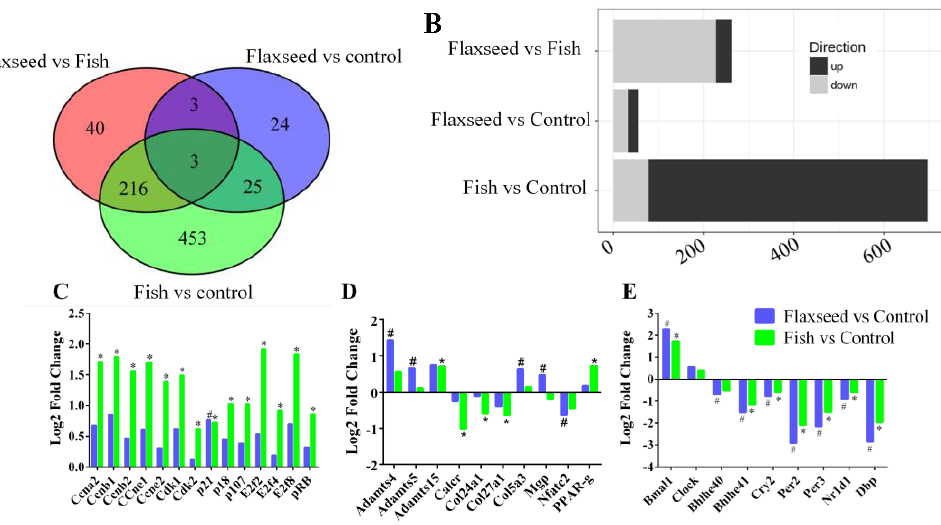
Figure 6. ( A ) Venn diagrams indicating the intersection of differentially expressed (DE) genes that have 1.5 or greater expression ( p < 0.05) in bone for each comparison. ( B ) Bar plots summarize the number of DE genes for each comparison. ( C ) DE genes related to the cell-cycle canonical pathway, ( D ) to bone modeling–remodeling processes, and ( E ) to the circadian rhythm pathway. Differential expressed cutoff was set at p -value ≤ 0.05, log-2-fold change ≥0.595, min counts ≥30. Raw p-